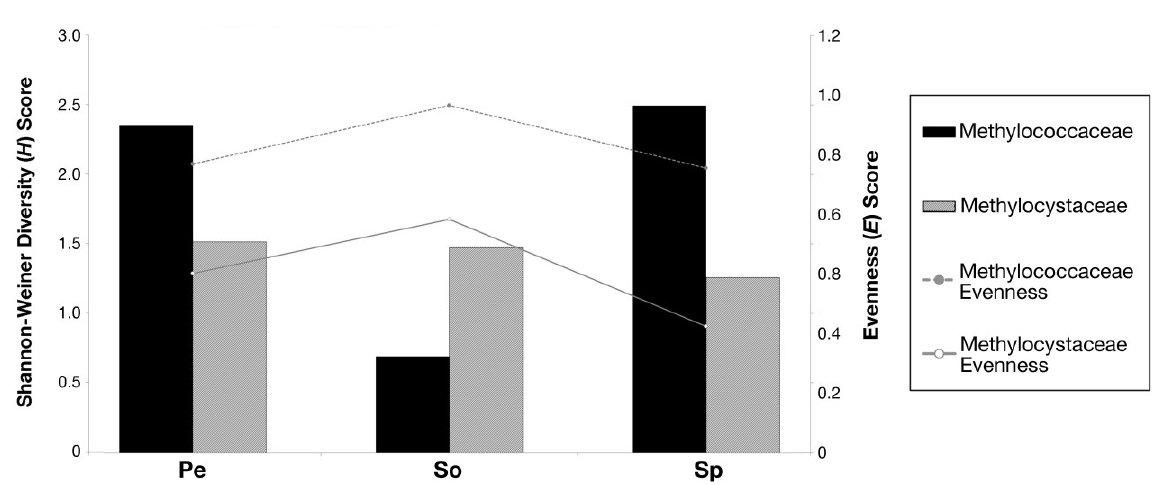
Figure 5. Calculated Shannon-Weiner ( H ) and evenness ( E ) indices for methanotroph 16S rRNAs related to the Methylococcaceae and Methylocystaceae for each habitat—surface peat, forest soil, and Sphagnum moss. Pe, peat; So, forest soil; Sp, Sphagnum moss. 3.6. NMDS Analysis of 16S rRNA Sequences Related to the Methylococcaceae and